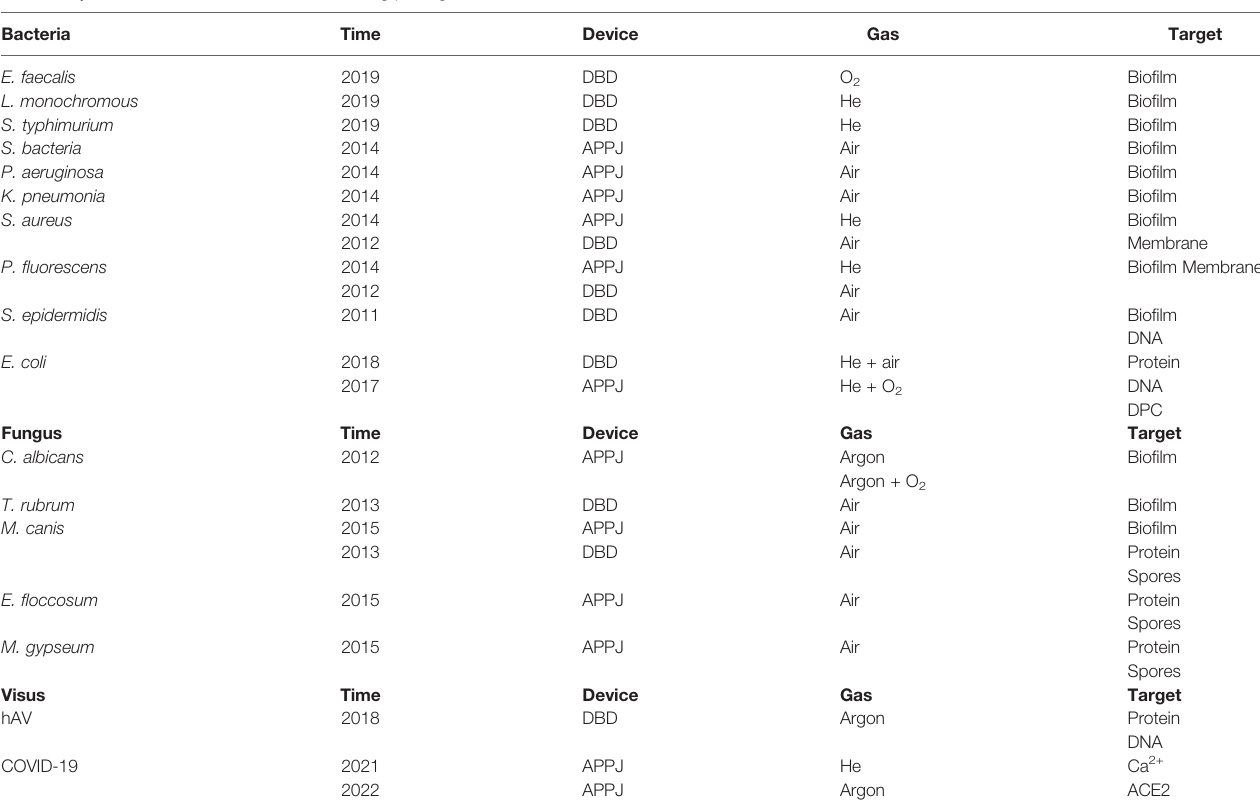
TABLE 1 | The mechanisms of CAP for inactivating pathogens. Bacteria